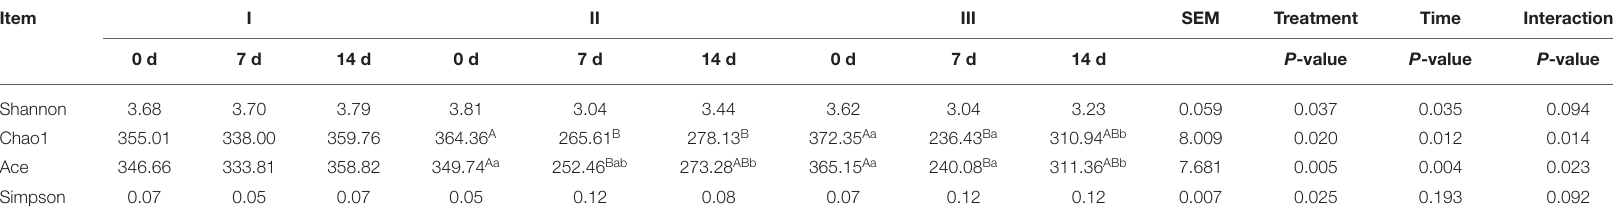
TABLE 4 | α diversity analysis results (Multiple comparisons between treatment at a specific time).